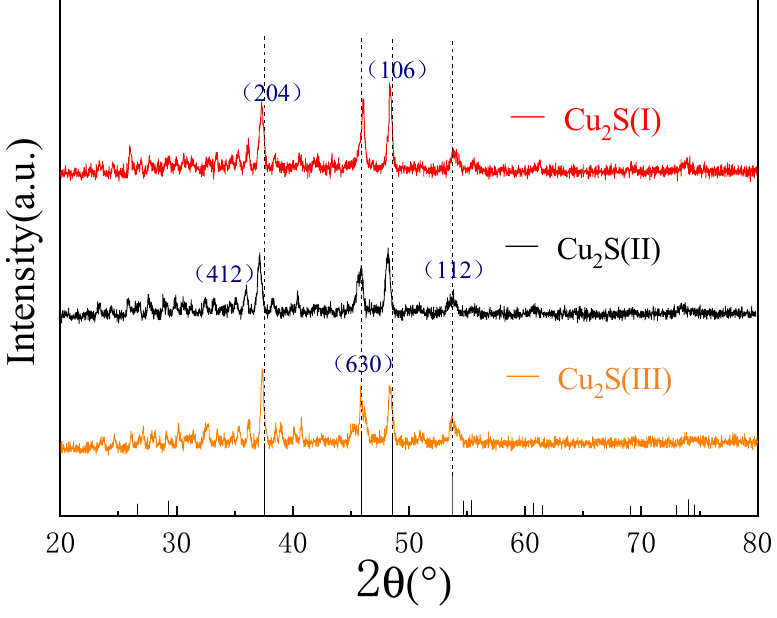
Figure 6. XRD patterns of cuprous sulfide with three different morphologies: Cu 2 S(I), Cu 2 S(II), and Cu 2 S(III).